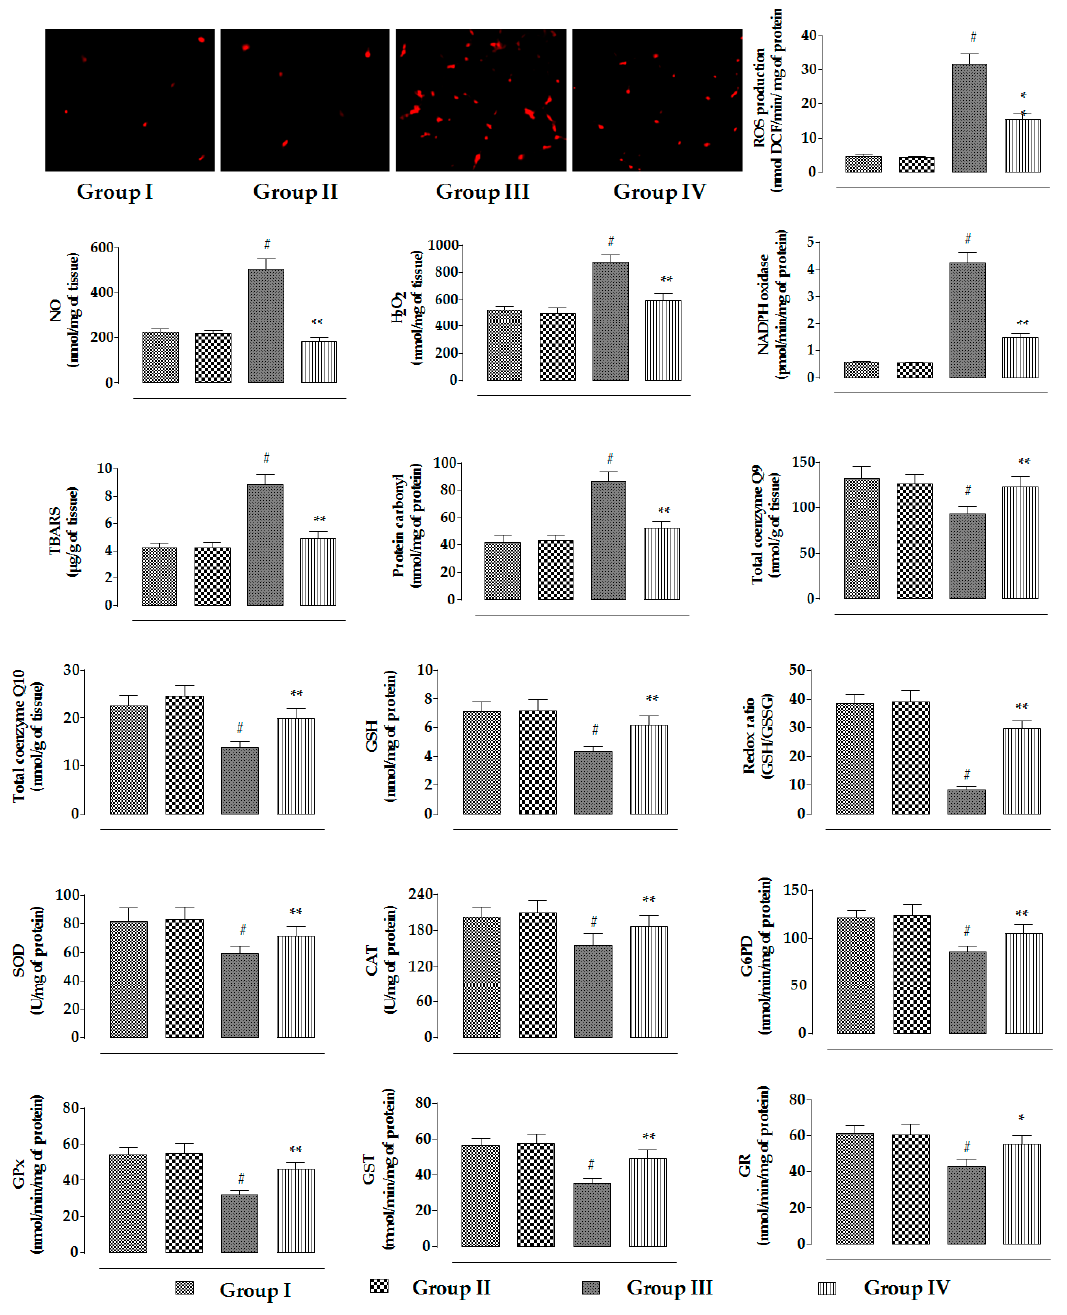
Figure 3. The effects on the ROS accumulation, NO production, H 2 O 2 level, NADPH oxidase activity, extent of lipid peroxidation, extent of protein carbonylation, co-enzyme Q9 level, co-enzyme Q10 level, and the levels of endogenous redox markers in the absence (CdCl 2 ) and presence of RA (CdCl 2 + RA) in vitro on mouse proximal tubular epithelial cells. Data are represented as means ± SD, n = 3 (number of plates). # Values significantly ( p < 0.01) differ from normal control. * Values significantly ( p < 0.05) differ from CdCl 2 control. ** Values significantly ( p < 0.01) differ from CdCl 2 control. SOD unit, “U”, is defined as inhibition ( μ moles) of NBT reduction/min. CAT unit, “U”, is defined as H 2 O 2 consumption/min. Group I: untreated, Group II: RA (40 μ M), Group III: CdCl 2 (40 μ M), and Group IV: CdCl 2 (40 μ M) + RA (40 μ M).